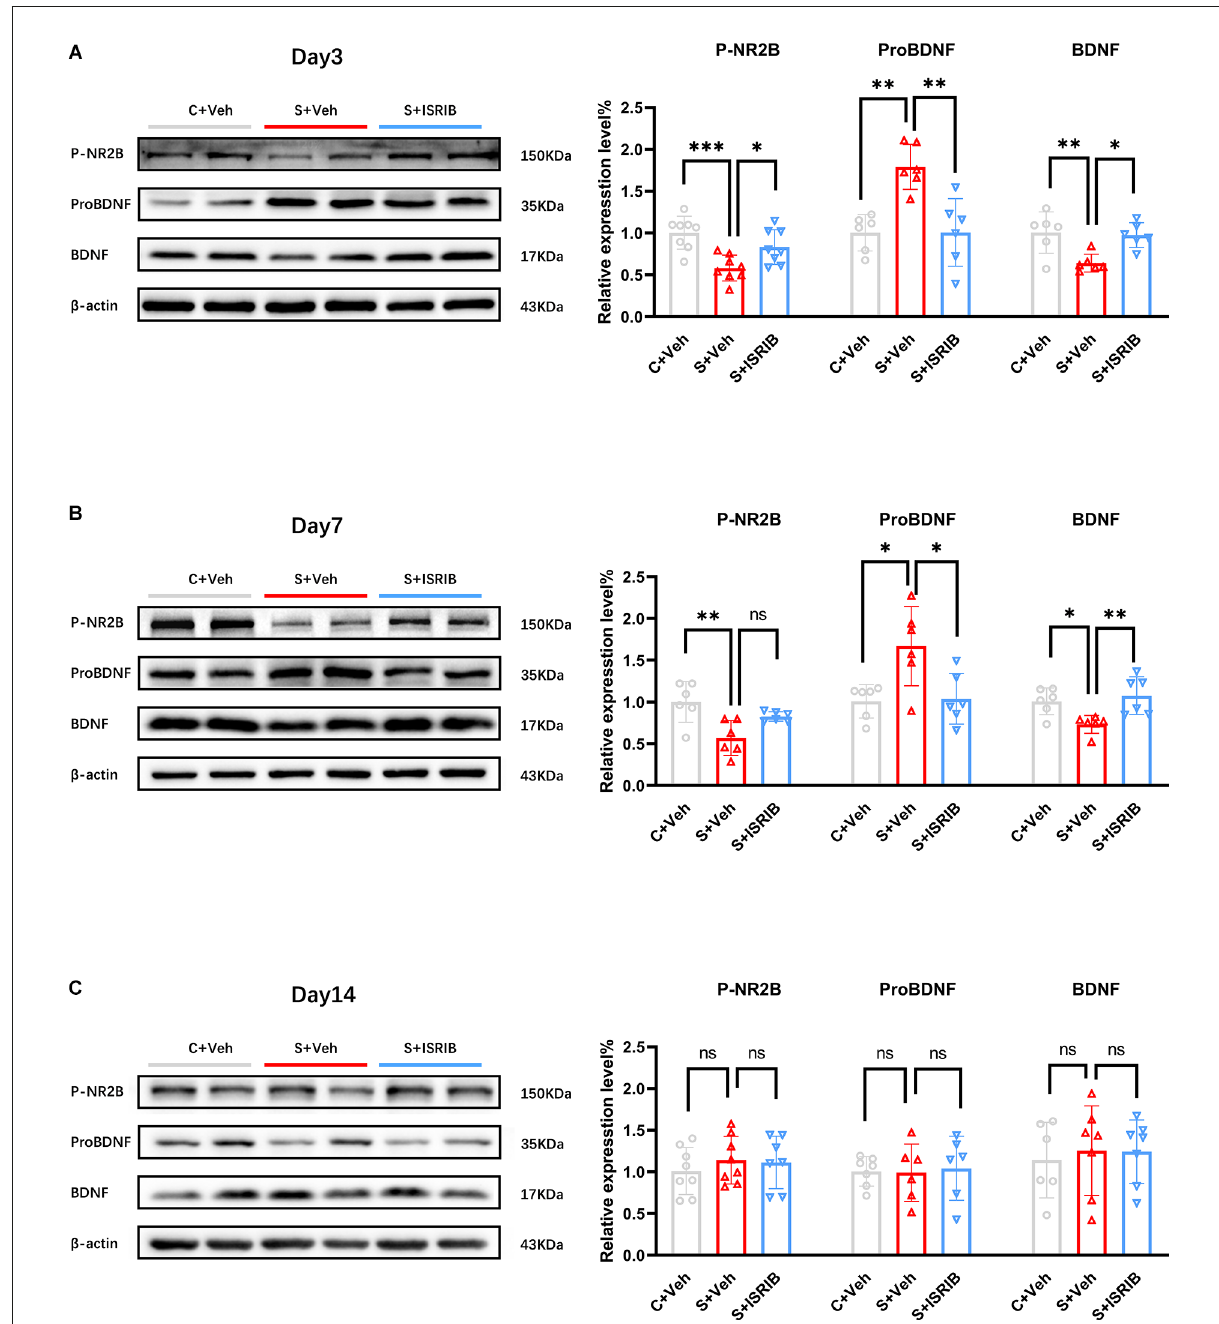
FIGURE5 Effect of ISRIB pretreatment on levels of P-NR2B, ProBDNF, and BDNF protein expression in POCD mice. (A) Changes in P-NR2B, ProBDNF, and BDNF protein expression at post-surgery day 3 in all groups. Representative protein bands are shown on the left and quantification are shown on the right. (B) Changes in P-NR2B, ProBDNF, and BDNF protein expression at post-surgery day 7 in all groups. (C) Changes in P-NR2B, ProBDNF, and BDNF protein expression at post-surgery day 14 in all groups. One-way ANOVA was used for statistical analysis. ∗ p < 0.05; ∗∗ p < 0.01; ∗∗∗ p < 0.001; ns: no statistical difference.